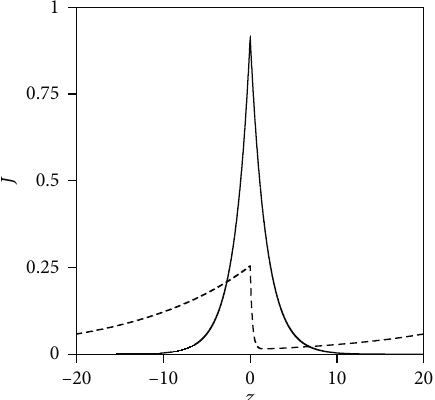
Figure 5: Pro fi les of the kernel given by Equation (7) under periodic boundary conditions. L = 2 0. Solid and dashed curves represent cases of c = 0 and 4, respectively.